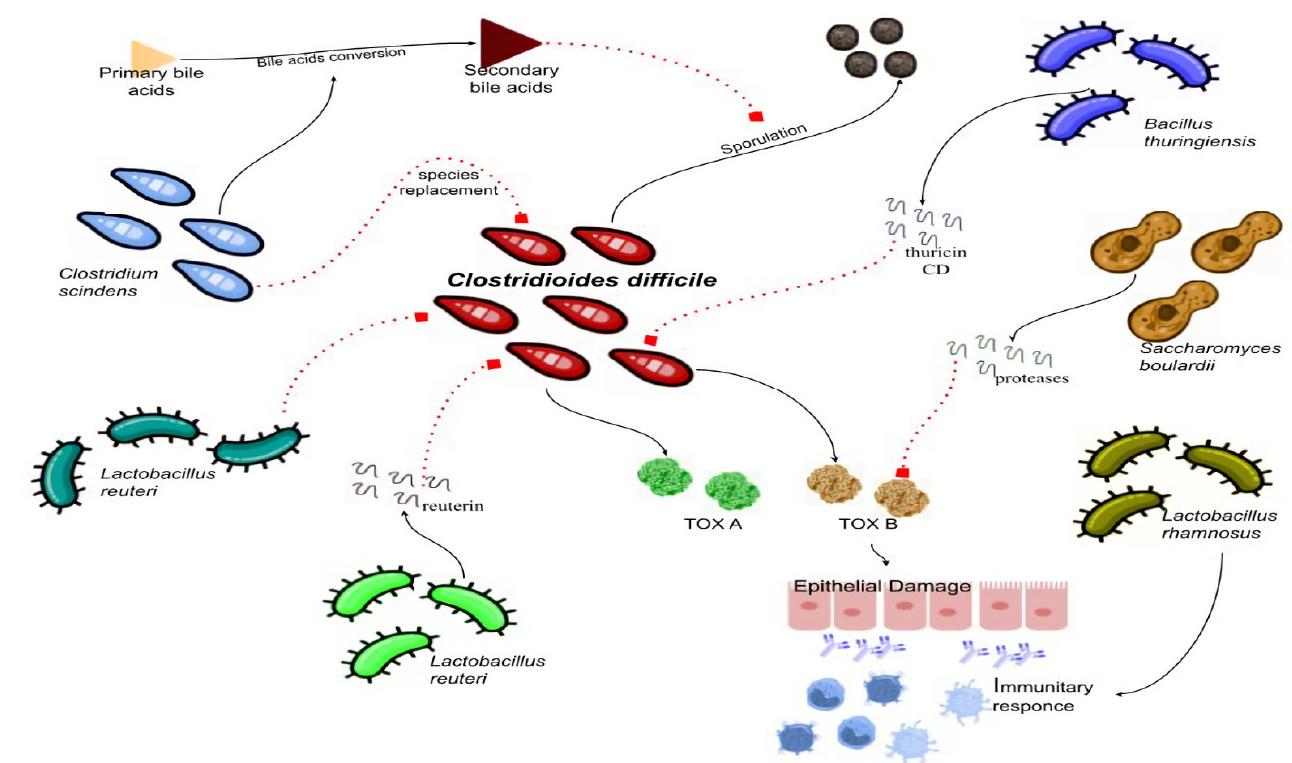
Figure 1. Possible effects of different bacterial strains on CDI infection. Continuous lines indicate stimulation; dashed lines indicate inhibition. CD—Clostridioides Difficile.